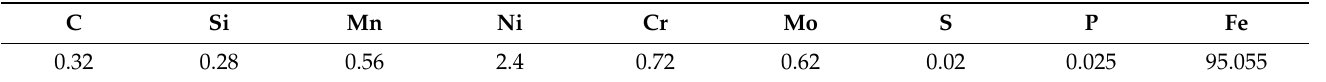
Table 1. Chemical composition of the investigated EN25 steel in